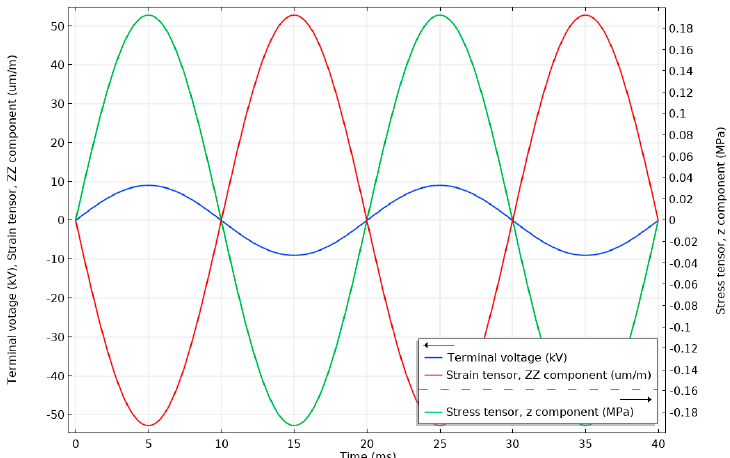
Figure 12. Instantaneous terminal voltage, stress and strain in the stack when subjected to a nominal 6.35 kV (RMS) voltage. Stress and strain are measured on the surface of the stack in the middle of its thickness.